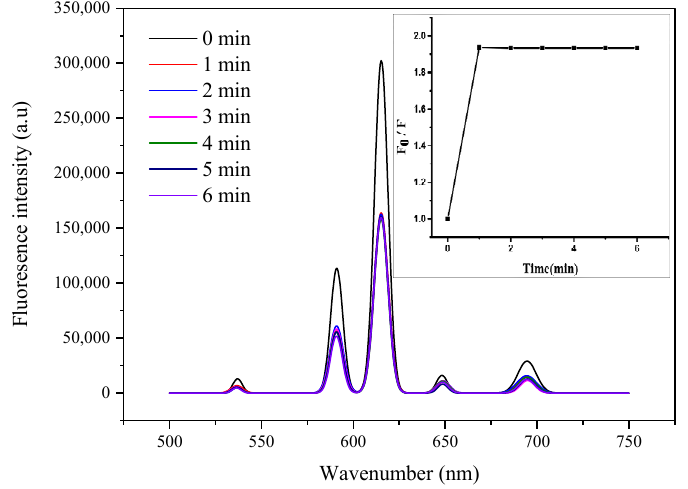
Figure 4. Effect of reaction time on the fluorescence intensity of CMC/Eu (III) probe at 544 nm (F 0 , pure